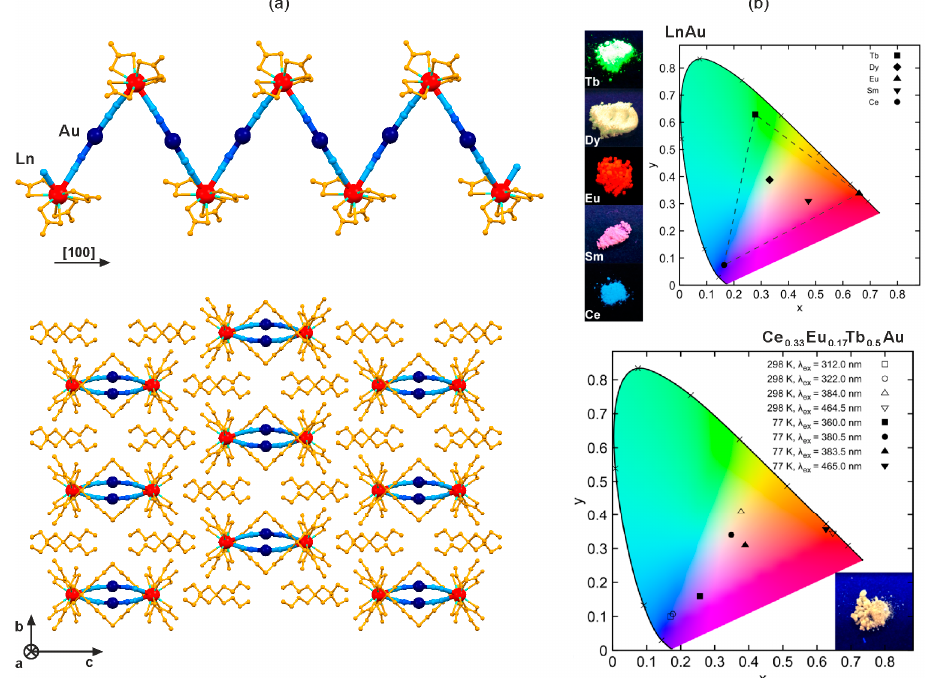
Figure 2. Crystal structure and optical properties of cyanido-bridged ( n Bu 4 N) 2 [Ln III (NO 3 ) 4 ][Au I (CN) 2 ] (Ln = Ce, Nd, Sm, Gd, Eu, Tb, Dy) chains: ( a ) the views of the single coordination chain, and the arrangement of chains, ( b ) the multi-coloured lanthanide-dependent emission of LnAu chains together with the related photos under UV light (top), and the multi-coloured temperature- and excitation-dependent emission of Ce 0.33 Eu 0.17 Tb 0.5 Au chains together with the photo under UV light, all presented on the CIE 1931 chromaticity diagram. Colours for the structural diagrams: Ln, red; Au, dark blue; CN − , blue; NO 3 − and n Bu 4 N + , orange [67,69]. Reprinted with permission from Inorg.